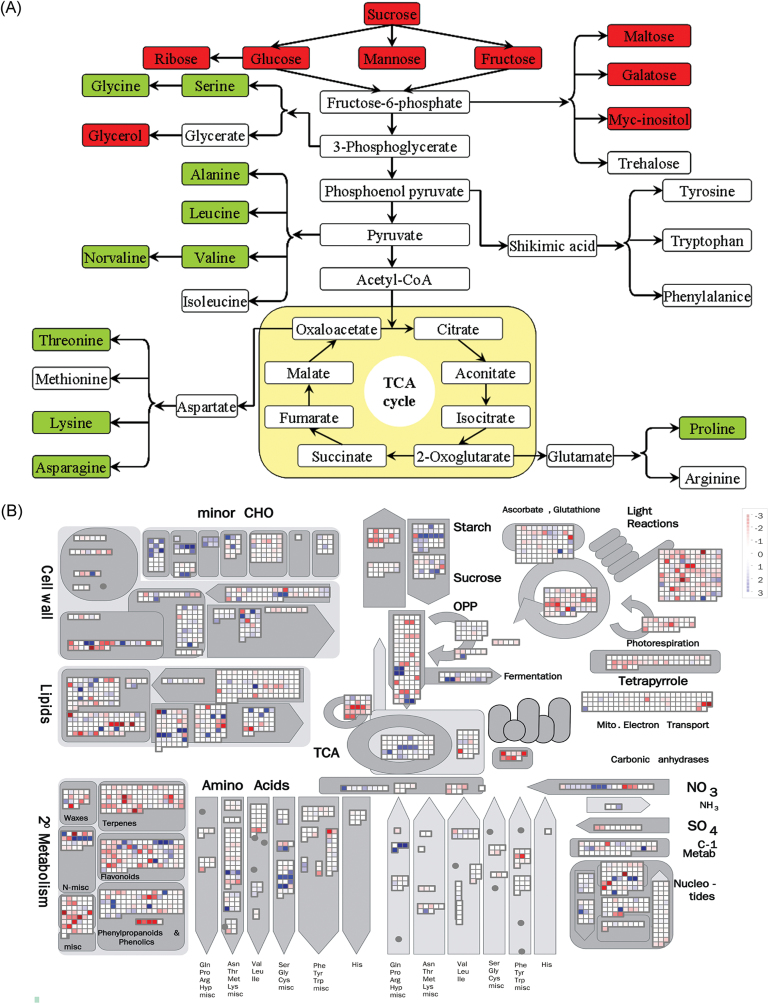
The effects of melatonin on the metabolites that were involved in the carbon metabolic pathway. (A) Assignment of the 18 metabolites from 54 assayed metabolites to the carbon metabolic pathway. The concentrations of these 18 metabolites are shown in Supplementary Table S2 at JXB online. (B) Effect of exogenous melatonin treatment on primary metabolism in bermudagrass. Transcripts participating in the same pathway or homologues are represented by a set of closely connected cubes, and the 2-based logarithm of fold change value (log2FC) is denoted. (This figure is available in colour at JXB online.)